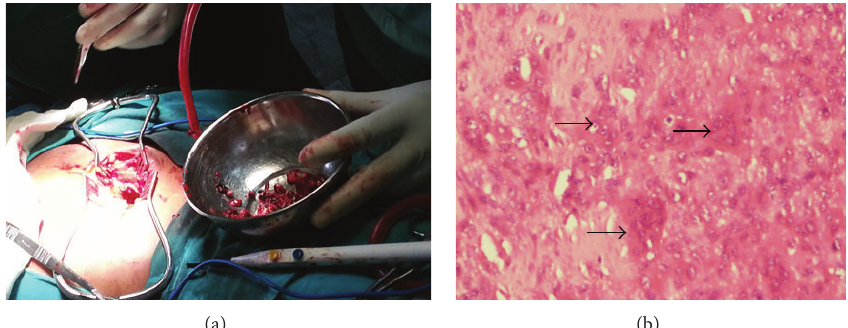
Figure 4: (a) Intraoperative photograph of curettage and bone grafting of the sacral lesion; (b) histopathology slide showing characteristic osteoclast like giant cells (arrows) in the background of mononuclear